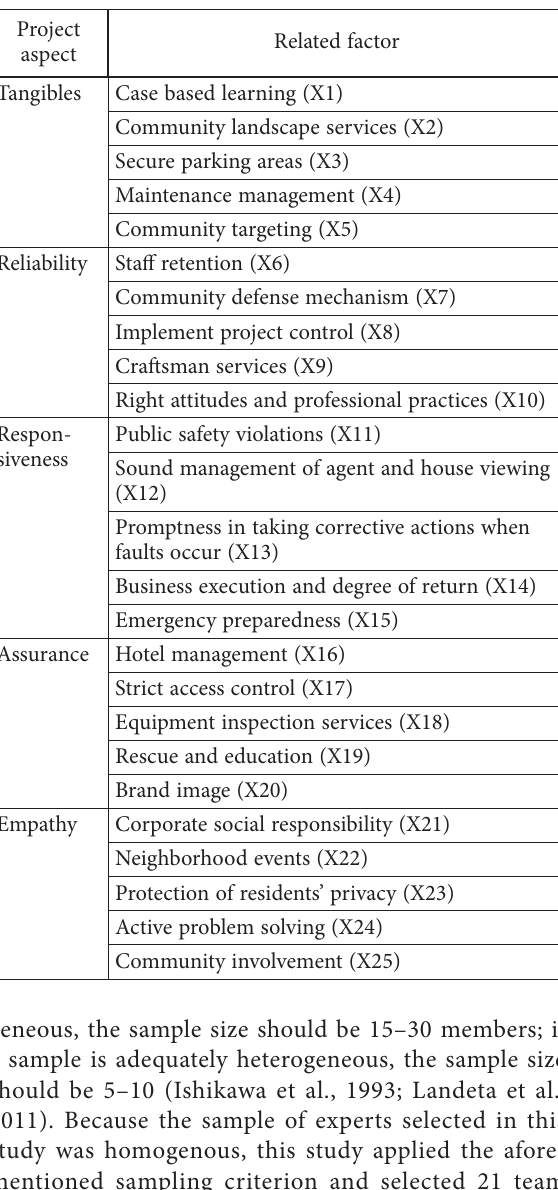
Table 2. Factors for assessment criteria